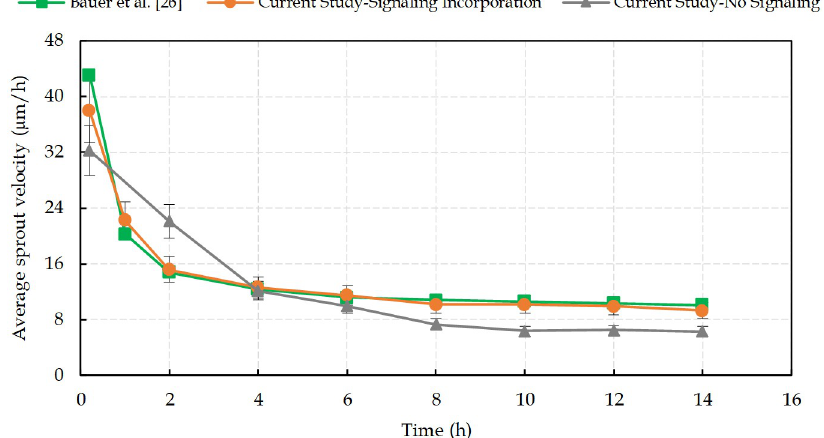
Fig 4. The average sprout extension velocity calculated from 5 independent simulations with and without including the intracellular signal transduction pathways, in comparison with experimental measurements extracted from Bauer et al. [26]. (Model validation; the error bars are the standard deviation on the mean of n = 5 simulation runs).